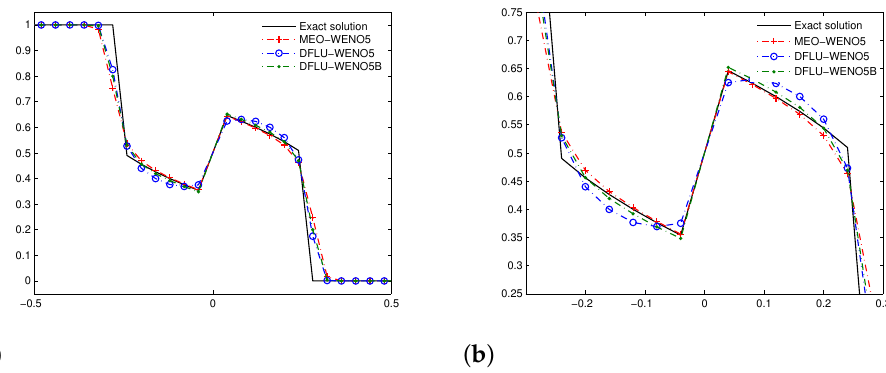
Figure 8. Example 2 computed by the MEO-WENO5, DFLU-WENO5, and DFLU-WENO5B with ∆ x = 1/25. ( a ): the numerical and exact solutions; ( b ): the numerical and exact solutions zoomed in.